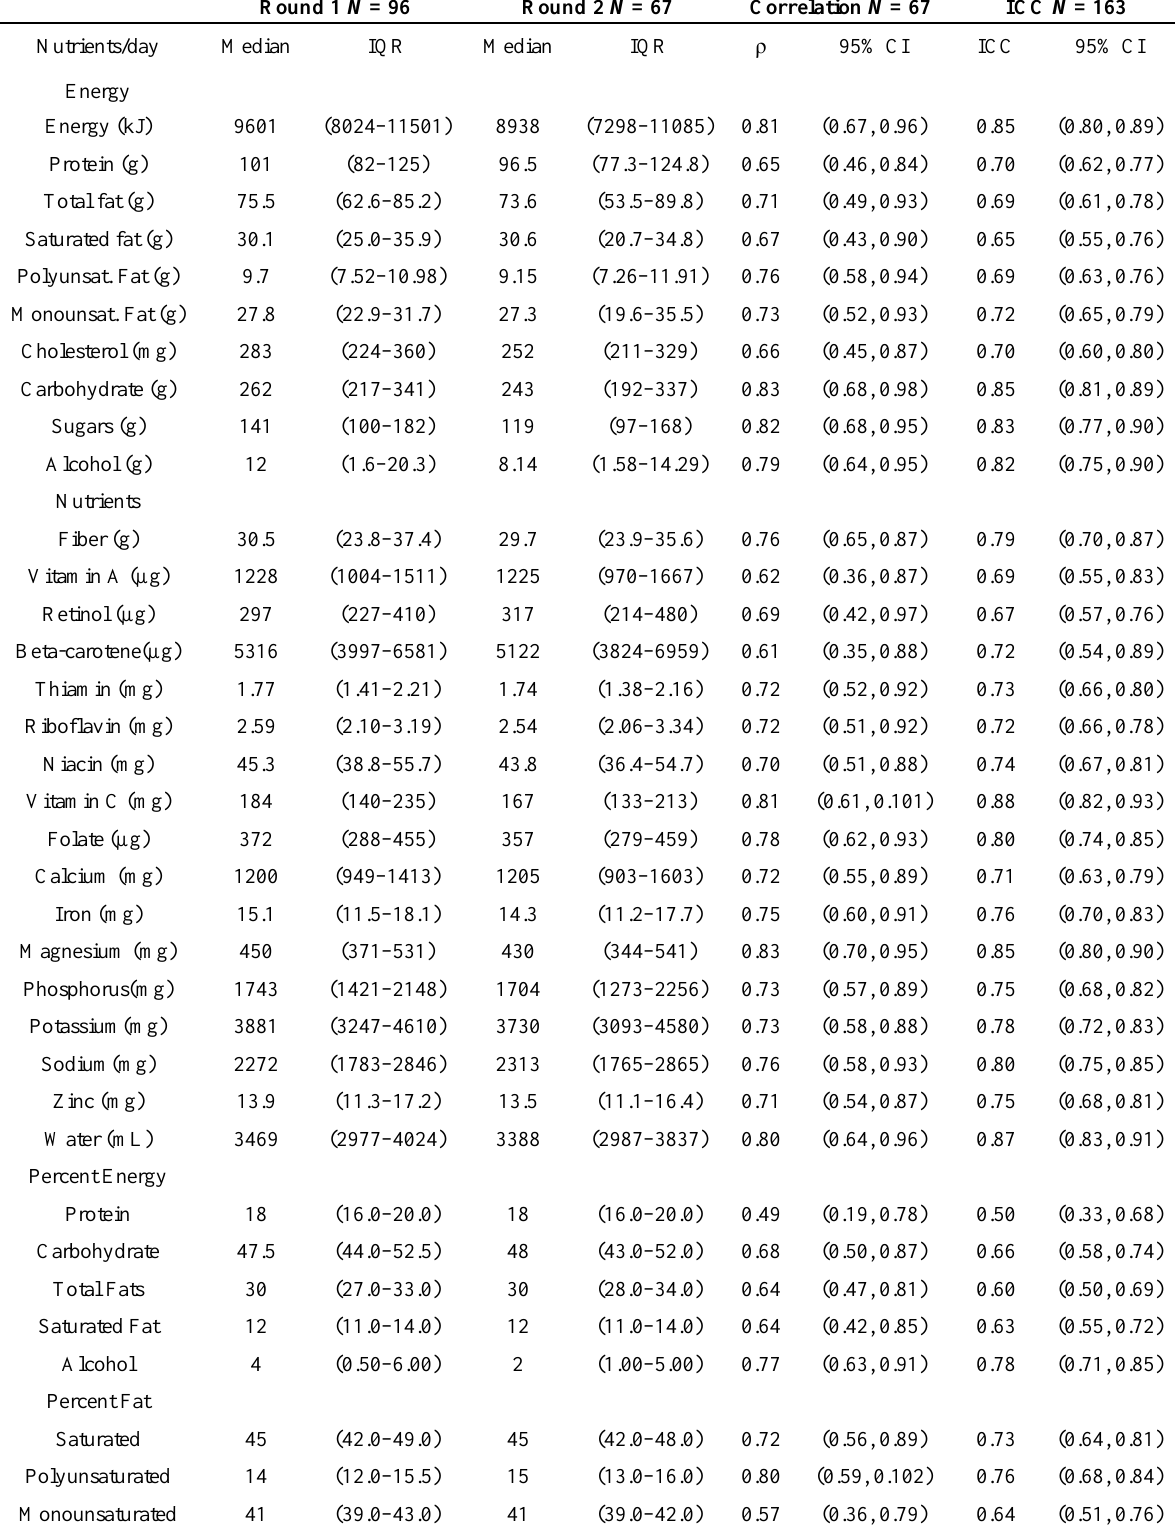
Table 3. Reproducibility of Food Frequency Questionnaire (FFQ) nutrients: Median, interquartile range (IQR) and correlation, with 95% confidence interval, between round 1 and round